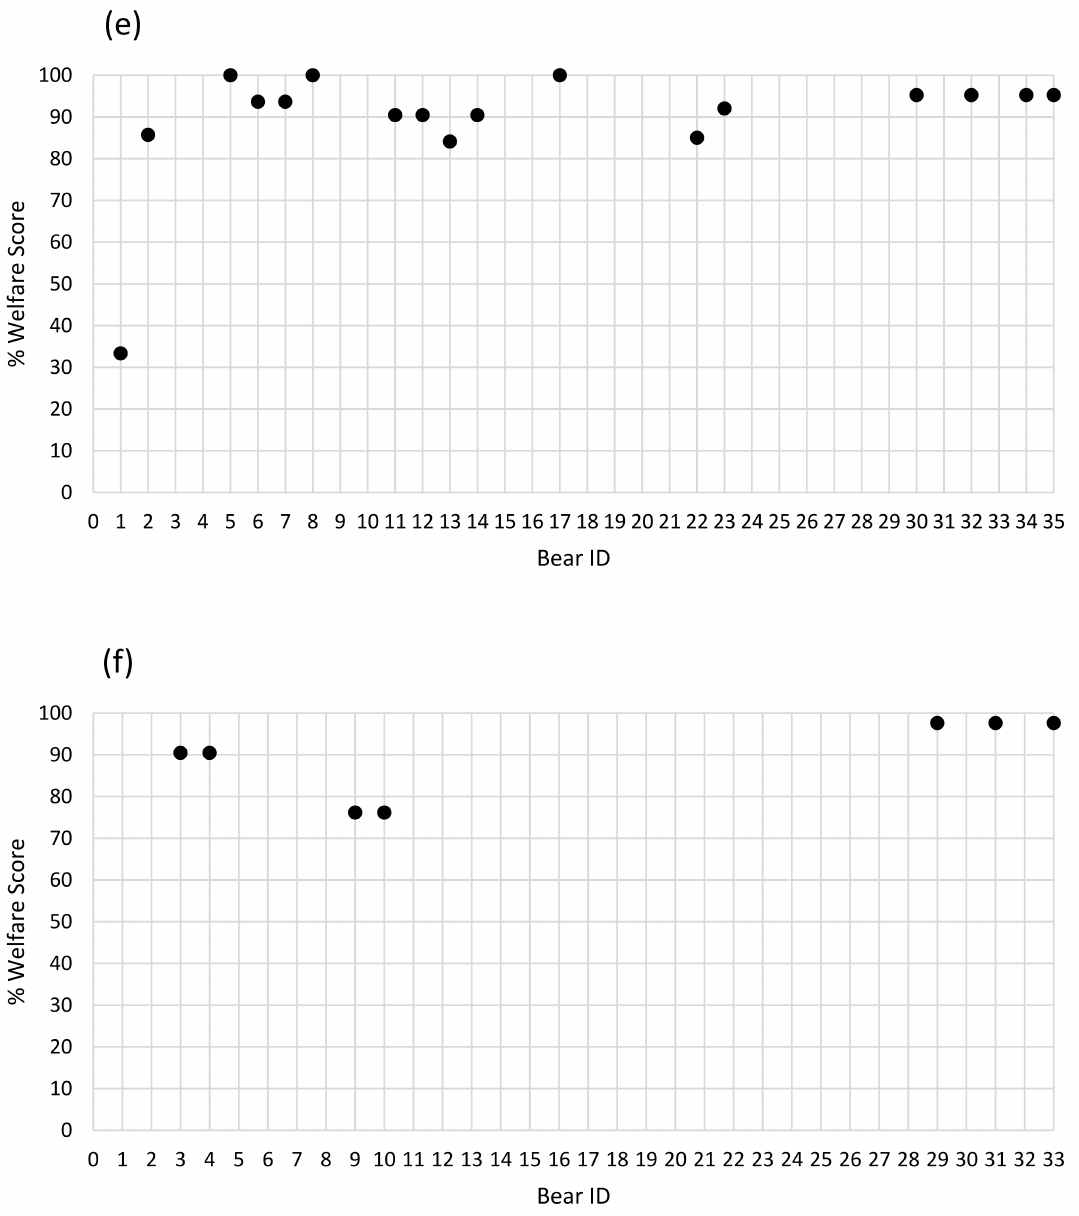
Figure 5. Percentage welfare scores showing: ( a ) physical health section for brown bears; ( b ) physical health section for American black bears; ( c ) behaviour section for brown bears; ( d ) behaviour section for American black bears; ( e ) environment section for brown bears; and ( f ) environment section for American black